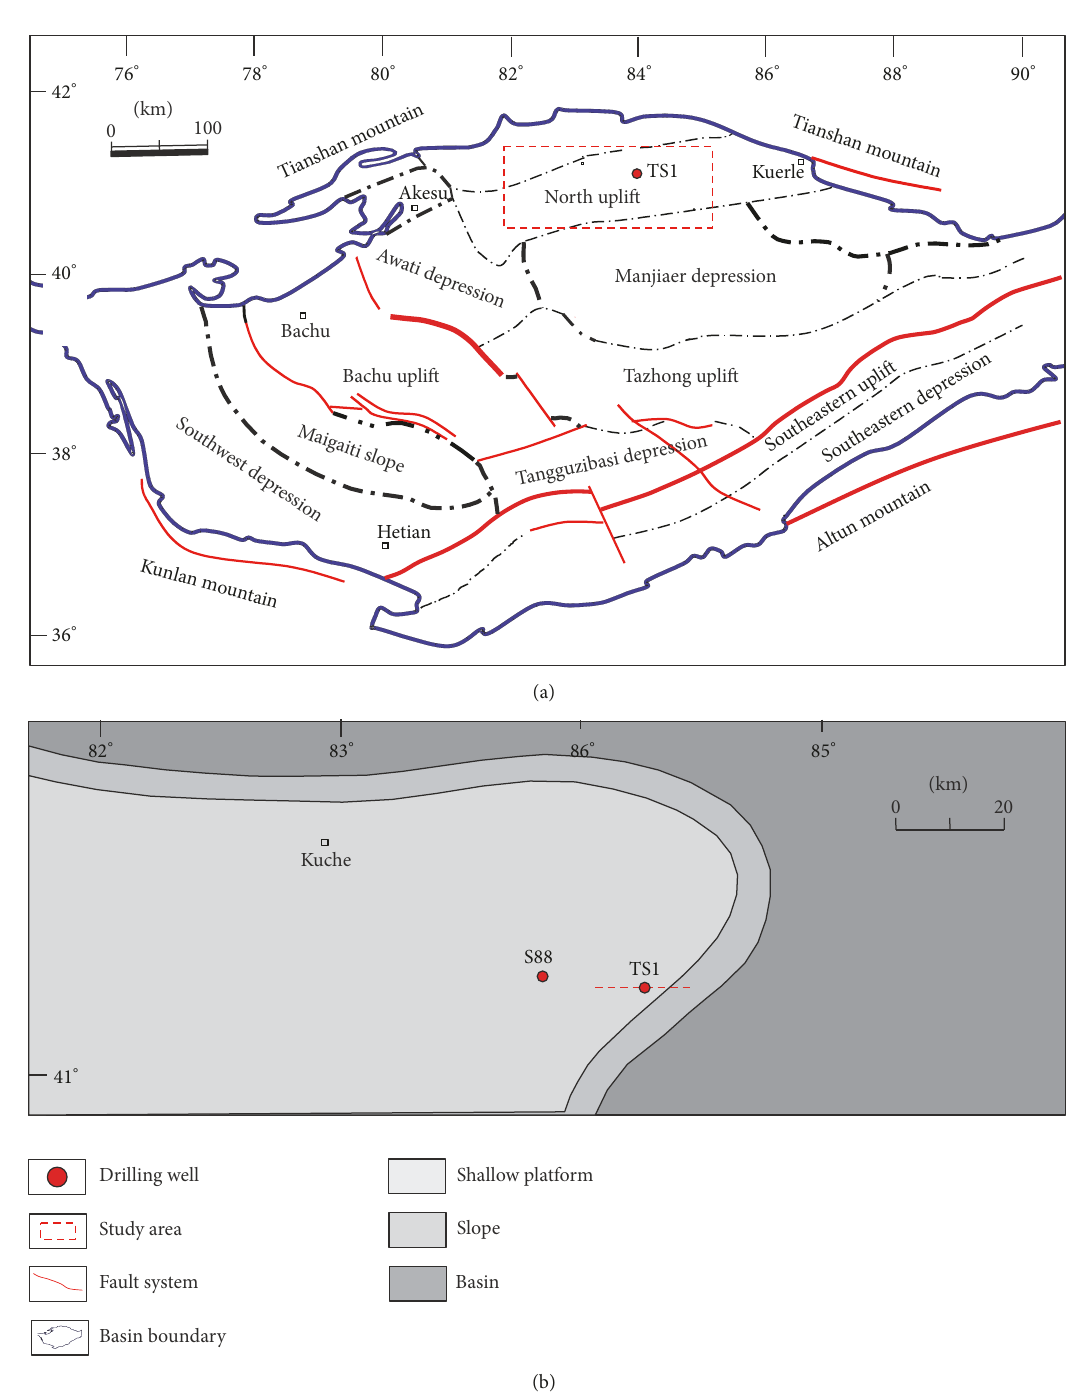
Figure 1: (a) Map of the Tarim Basin showing the main tectonic units (modified from He et al., [23]). Dashed rectangle denotes the location of study area and TS1. (b) Palaeogeographic setting of the northern Tarim Basin (study area) during the Cambrian period (modified from [17–21]). Dashed line indicates the location of seismic profile shown in Figure 3.